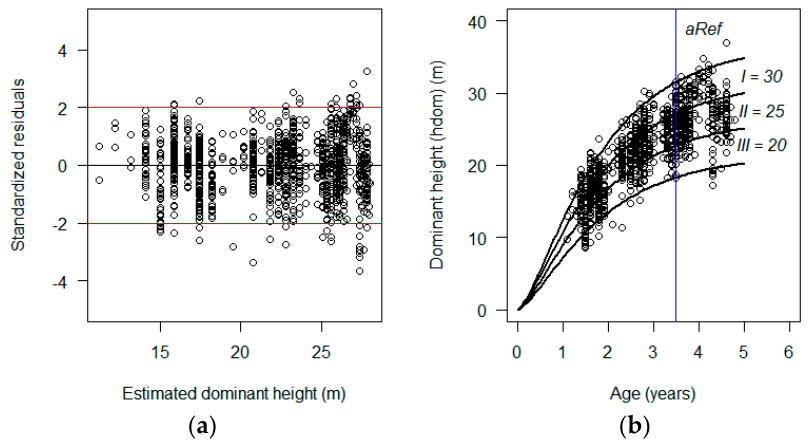
Figure 4. Standardized residuals for predicted h dom ( a ) and site-index curves ( b ) for Ochroma pyramidale (balsa-tree) stands in Ecuador.